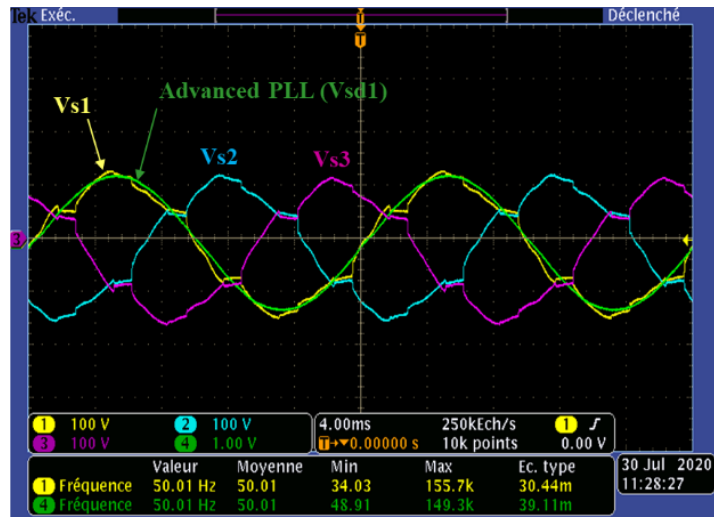
Figure 14. Experimental results of the three-phase grid voltage and positive sequence voltage.